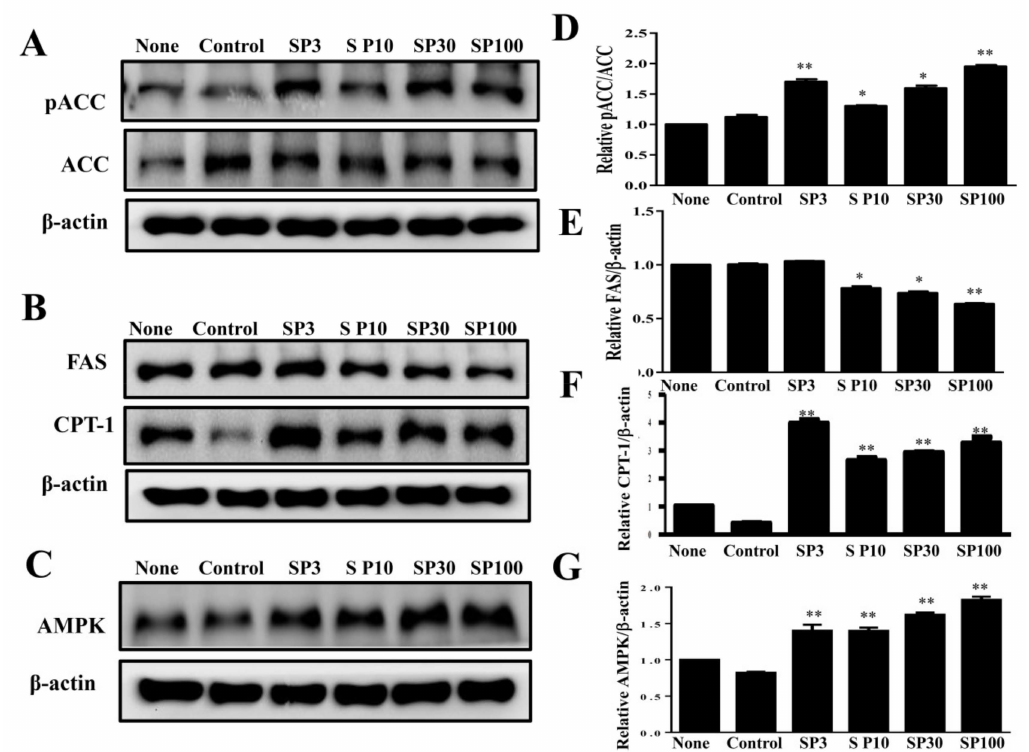
Figure 3. E ff ects of spilanthol (SP) on lipogenic and AMP-activated protein kinase (AMPK) protein expression in 3T3-L1 adipocytes. Di ff erentiated 3T3-L1 adipocytes (10 4 cells / mL) were treated with 3–100 µ M SP for 24 h. ( A ) Western blots of phosphorylated acetyl-CoA carboxylase (pACC) and ACC,